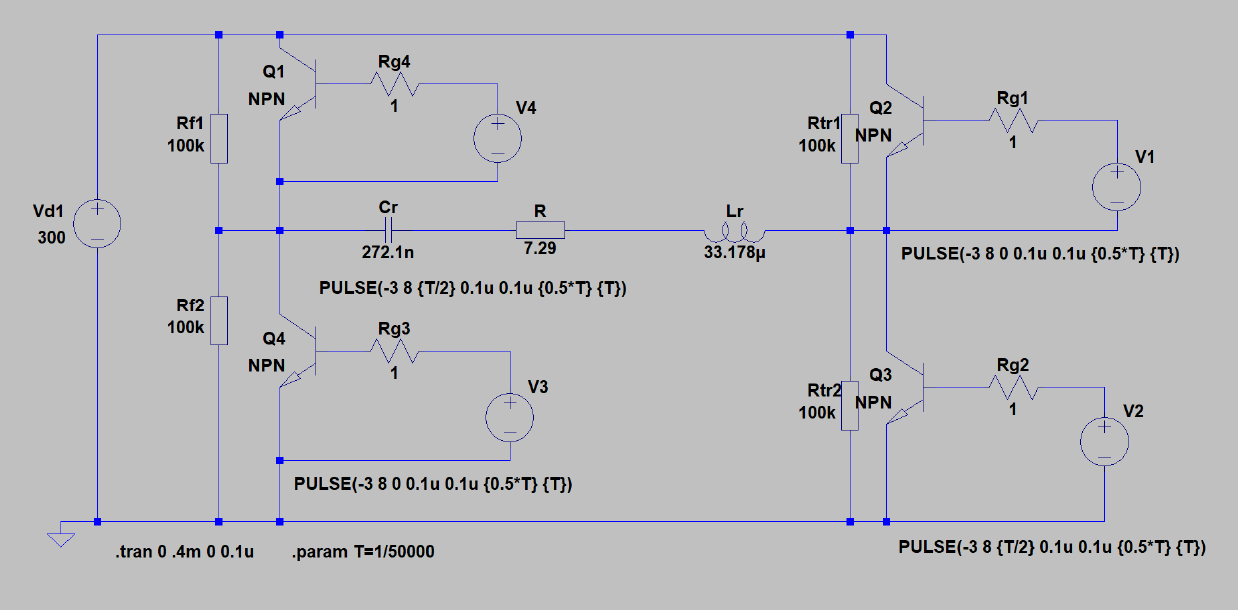
Figure A3. Simulation model of a series resonant inverter with reverse diodes. Figure A4 shows the simulation model of a voltage source inverter.